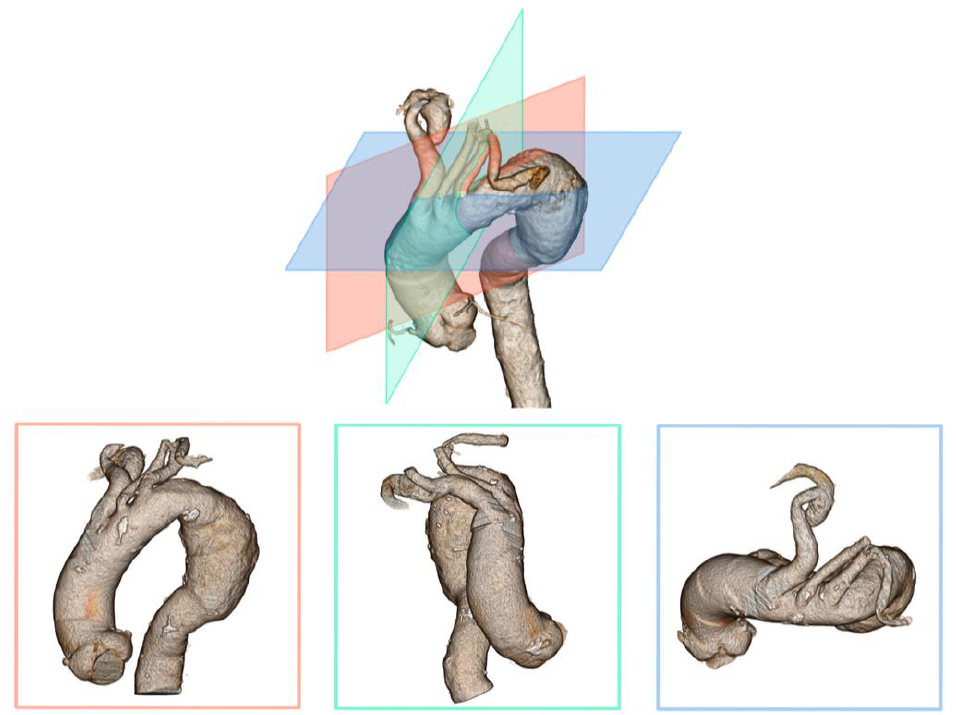
Figure 2. Three-dimension reconstruction of the aortic arch and the associated dimension graphic depicting the significance of the target vessel angle to the aortic wall in three planes.